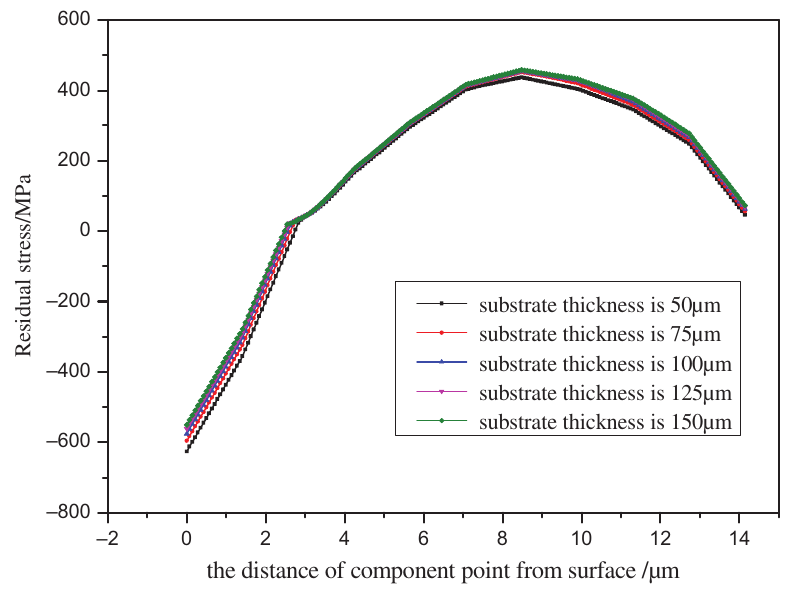
Figure 13: The effect of substrate thickness on residual stress in gradient direction.